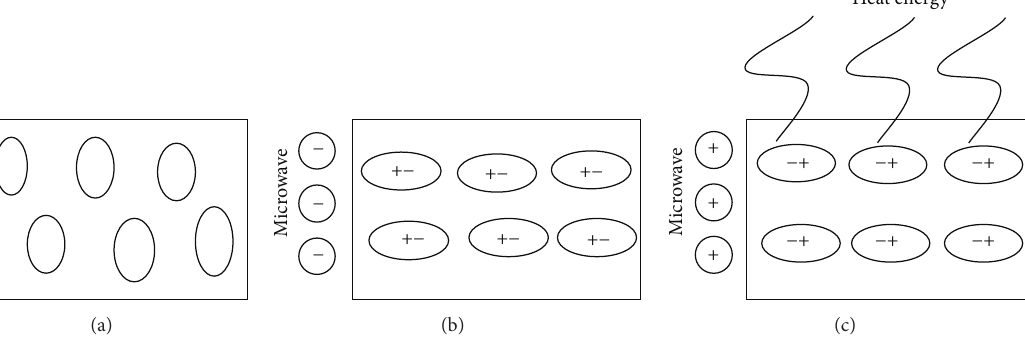
Figure 8: Schematic diagram of microwave heating. (a) Material distribution of molecules before microwave heating. (b) Distribution of materials during microwave heating. (c) Change in polarity under microwave field to generate